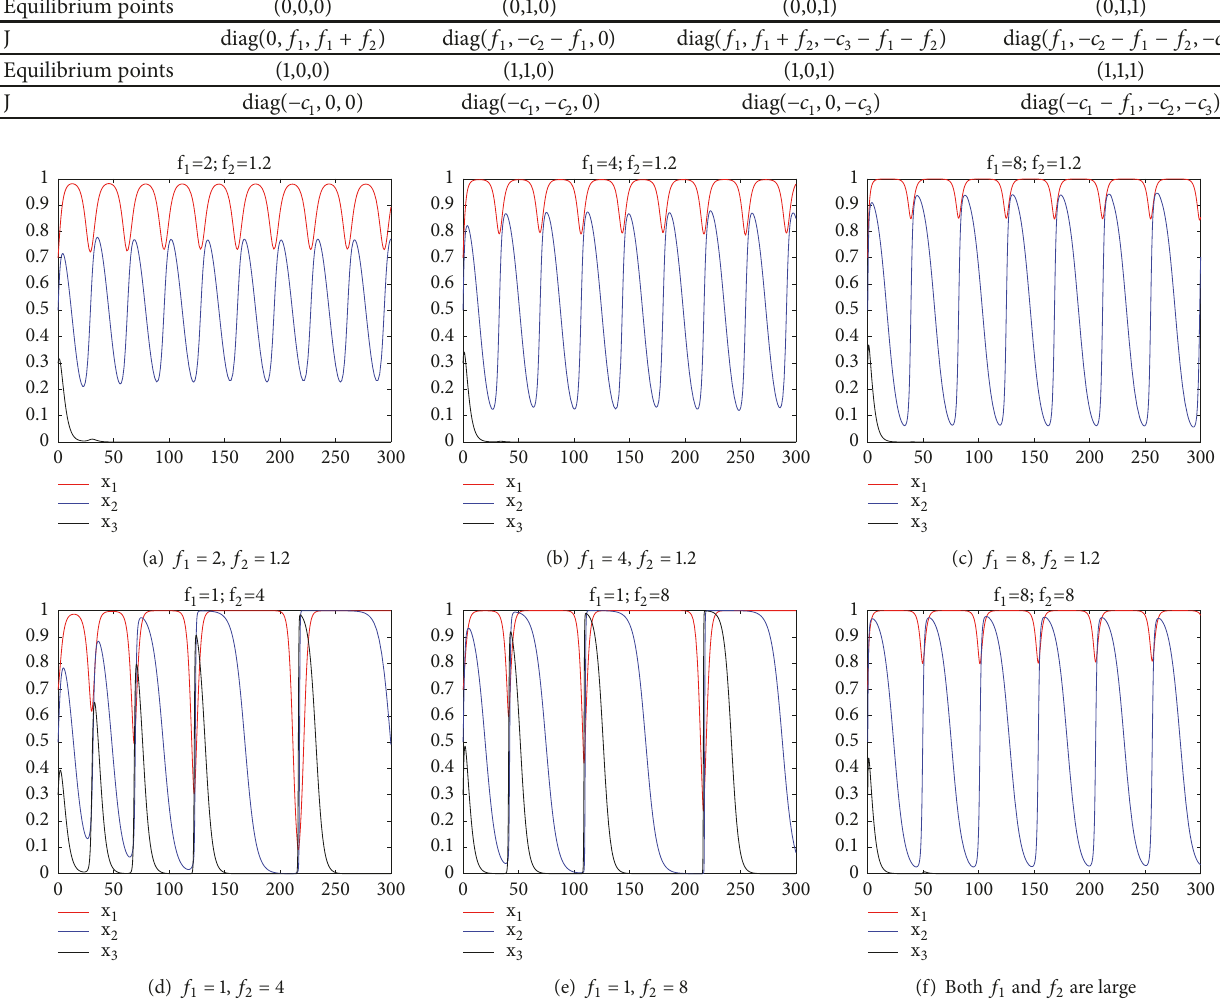
Figure 6: Time series graph of players’ strategyselection probability when 𝑓 1 or 𝑓 2 has larger values. Initial value of variables (𝑥 1 ,𝑥 2 , 𝑥 3 )| 𝑡=0 = 𝑃 (0.7,0.5, 0.3) 1